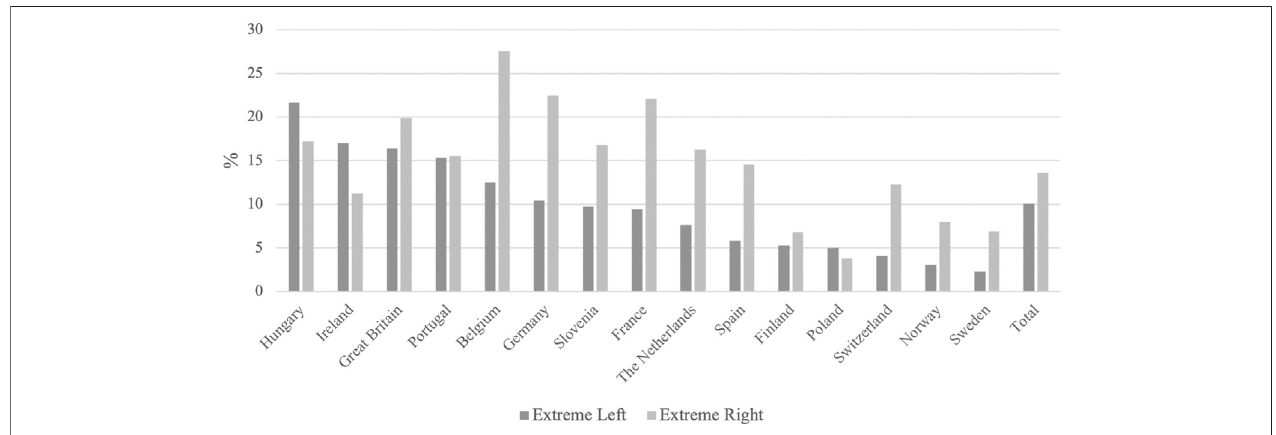
FIGURE 5 | Extreme Xenophobia Among the Far Left and Far Right by Country. Source: European Social Survey, cumulative dataset, waves 1 – 9. Own